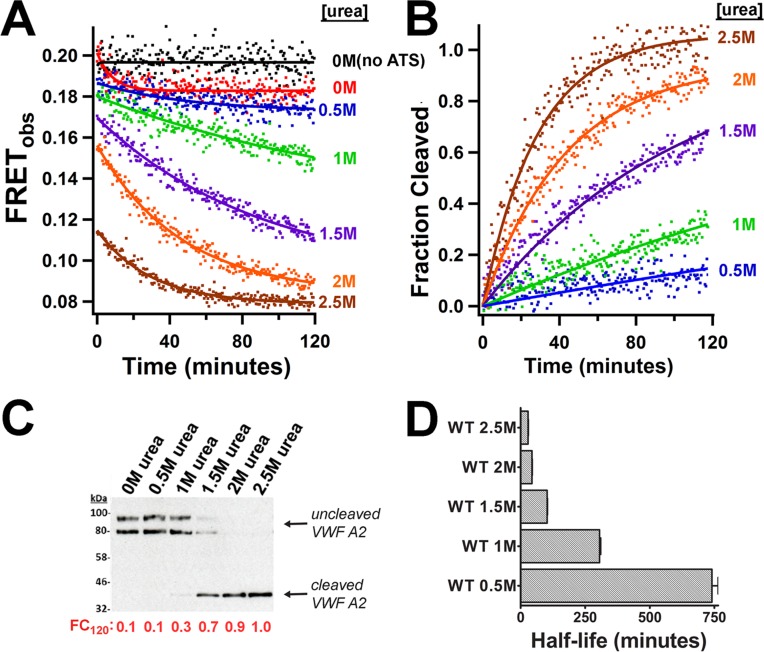
VWF A2 FRET is effectively proteolysed by ADAMTS13.A final concentration 50nM of the WT VWF A2 FRET construct and 50nM ADAMTS13 (or 0nM ADAMTS13 plus 0M urea, termed ‘no ATS’) were separately pre-incubated in 20mM Tris (pH7.8), 50mM NaCl, 1.25mM CaCl2 and varying concentrations of urea at 37°C for 45mins before being combined to initiate the proteolysis reaction. (A) Emission scans were taken at Ex505 every 0.5mins for 120mins, after 2mins ADAMTS13 was added and FRETobs plotted against time. (B) The FRETobs data was converted to ‘Fraction Cleaved’. (C) After 120mins reactions were stopped by the addition of EDTA followed by a western blot using an anti-Myc antibody. The calculated Fraction Cleaved after 120 minutes (FC120) is appended in red. (D) The half-life of proteolysis of the WT in differing concentrations of urea by 50nM ADAMTS13 was calculated by fitting the Fraction Cleaved data with an exponential rise function.